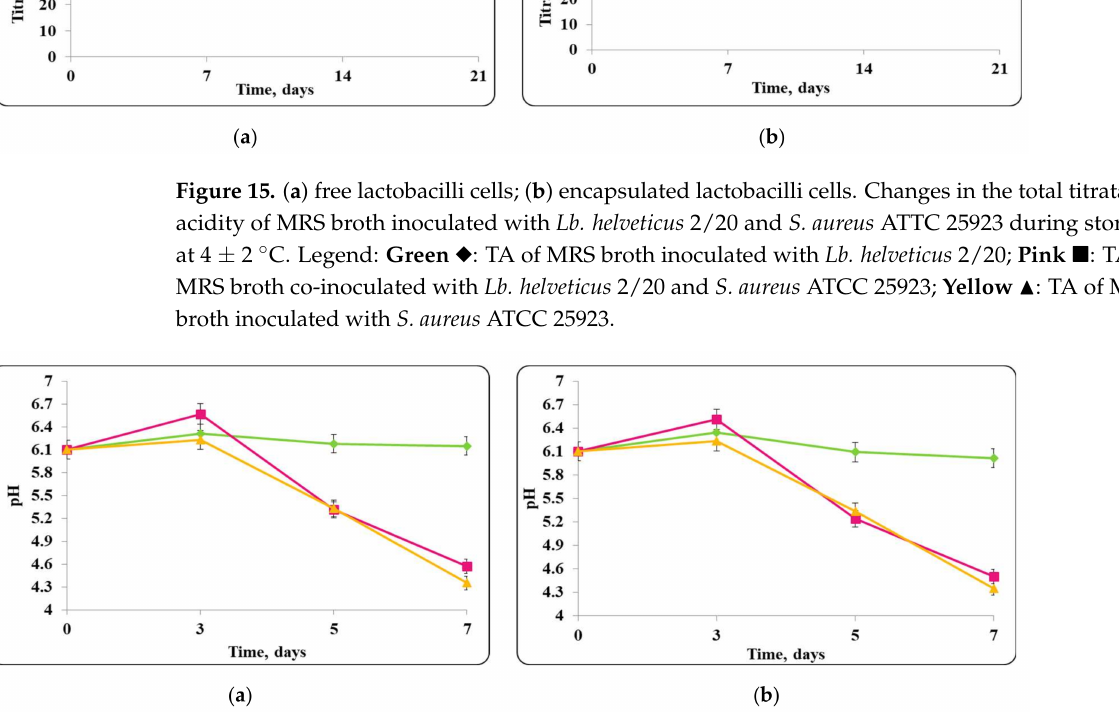
Figure 16. ( a ) free lactobacilli cells; ( b ) encapsulated lactobacilli cells. Changes in the pH of the chocolate mousse inoculated with Lb. helveticus 2/20 and S. aureus ATTC 25923 during storage at 20 ± 2 ◦ C. Legend: Green (cid:117) : pH of chocolate mousse inoculated with Lb. helveticus 2/20; Pink (cid:4) : pH of chocolate mousse co-inoculated with Lb. helveticus 2/20 and S. aureus ATCC 25923; Yellow (cid:78) : pH of chocolate mousse inoculated with S. aureus ATCC